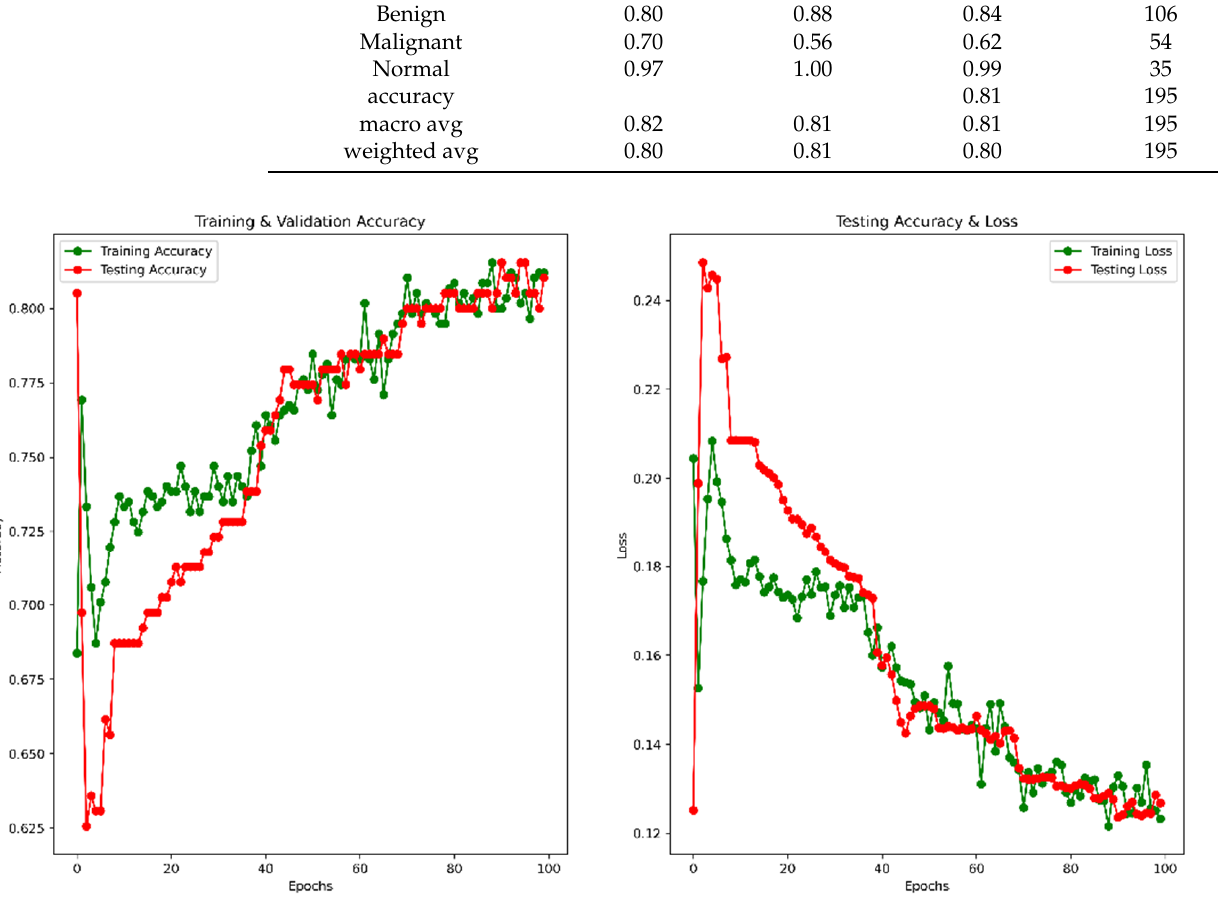
Table 2. Precision, Recall, and F1 score for the masked image on 25% of test data.